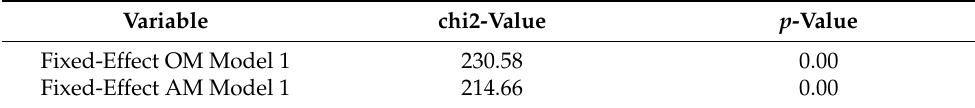
Table A4. Modified Wald Test for group (panel)